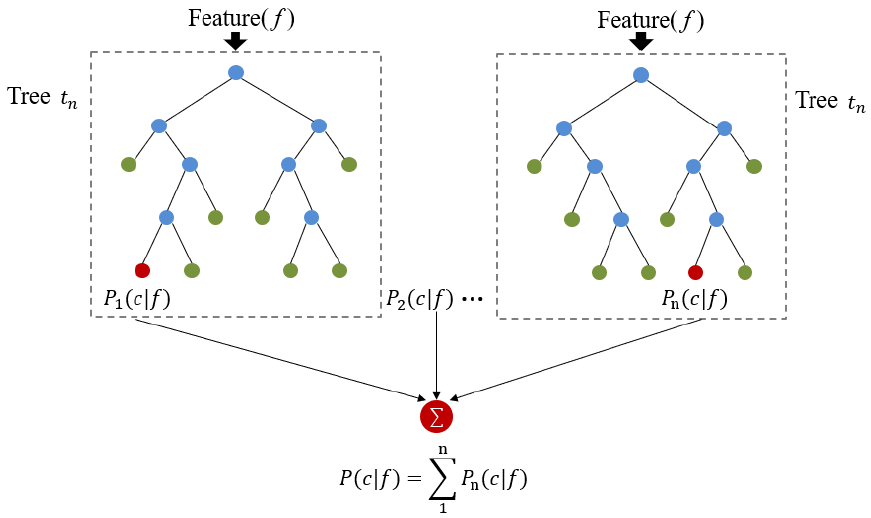
Figure 3. Schematic diagram of ETR algorithm.